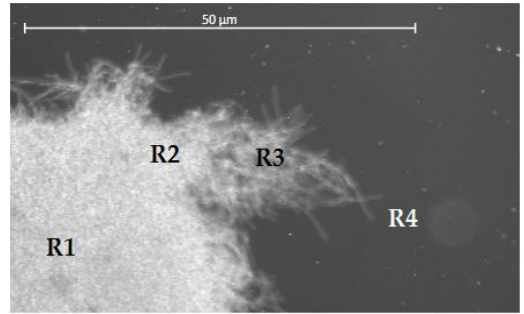
Figure 1. View of half a pellet from P. ostreatus in submerged culture. R1 is the central region of the pellet. R2 is the region of the peripheral hyphae. In R3, the most peripheral hyphae are far from R2. In R4, some hyphae in the peripheral region are separated. R4 corresponds to the so-called terminal hyphae in this study.